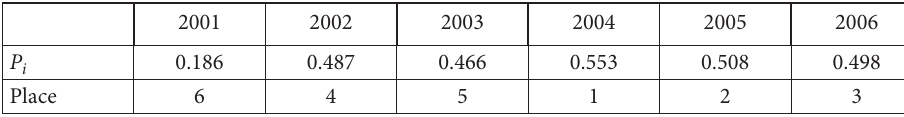
Table 7. Irrational decision making during 2001–2006 (source: authors’ calculations)